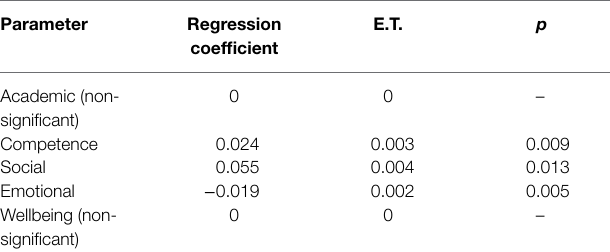
TABLE 7 | Results (regression coefficients and significant effects) for competence construct.